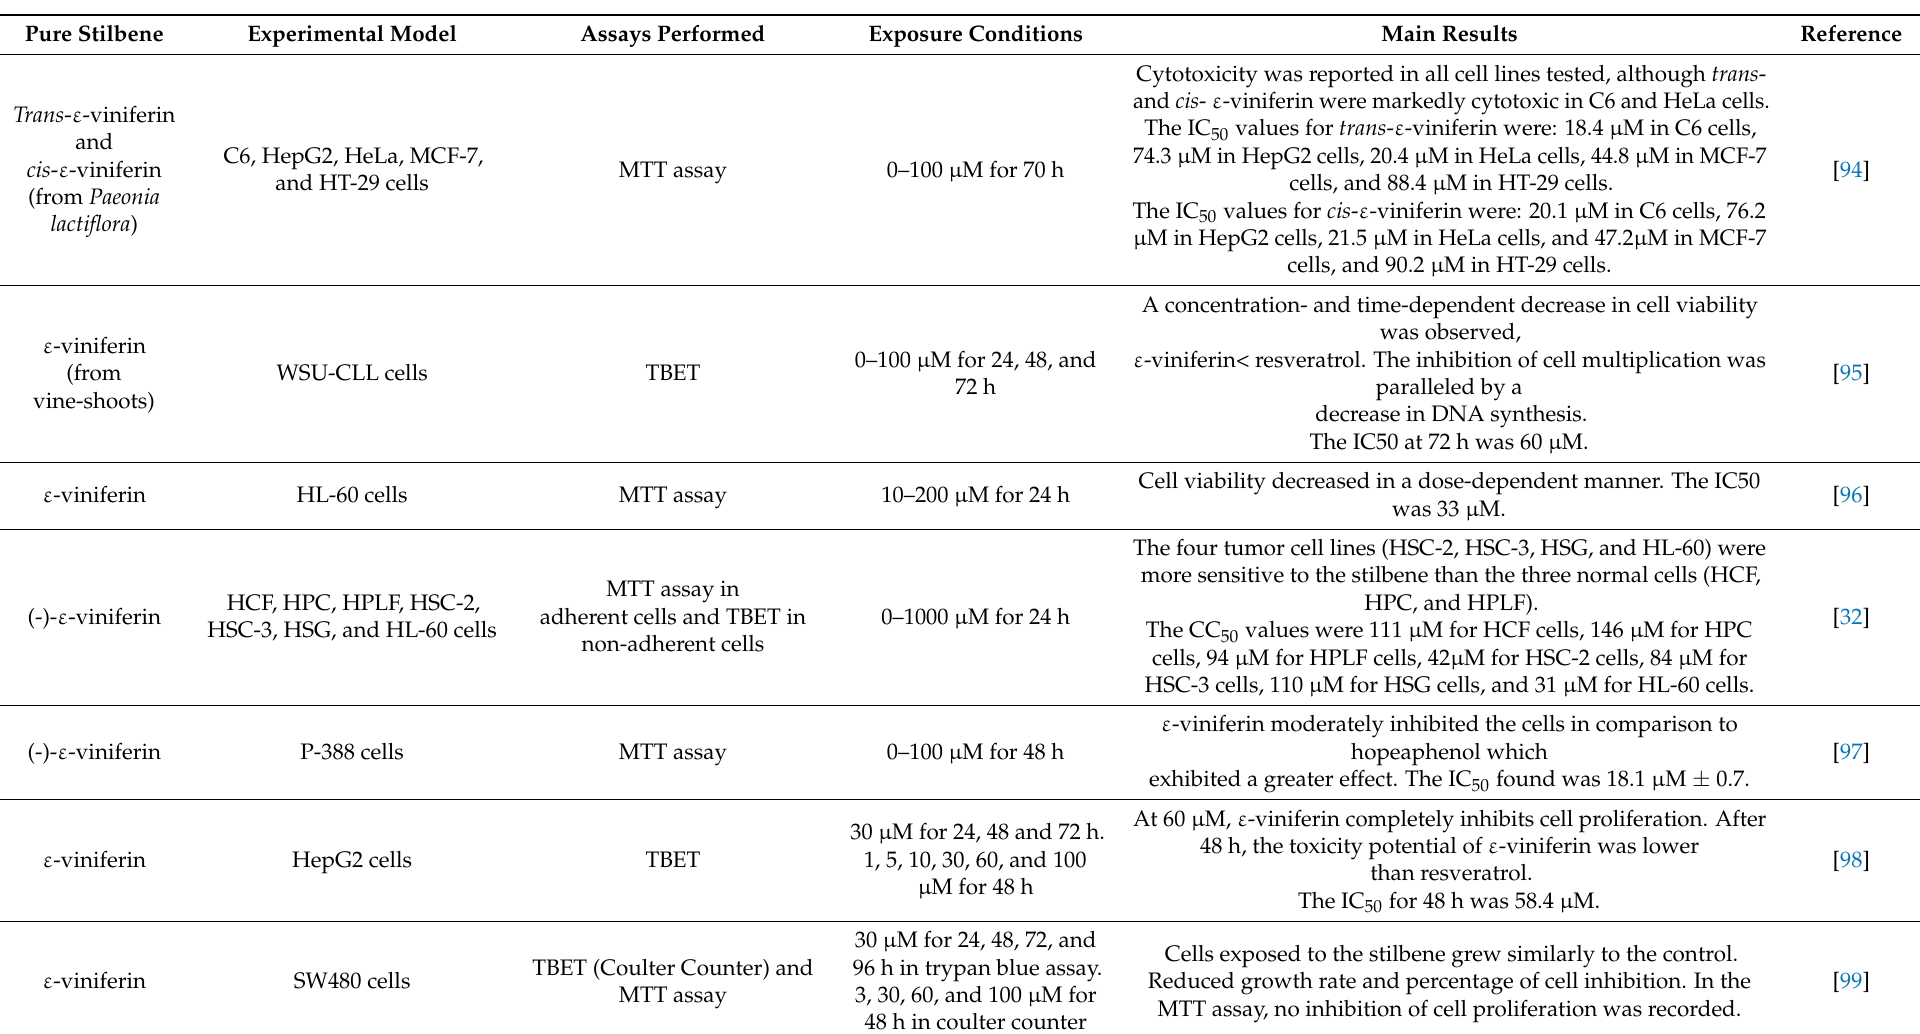
Table 5. In vitro cytotoxicity studies performed with trans - ε -